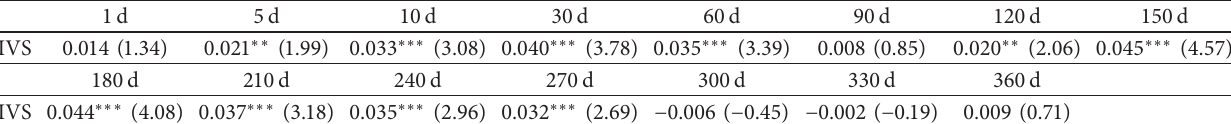
Table 9: Robustness test: forecasting power of volume weighted IVS on stock market